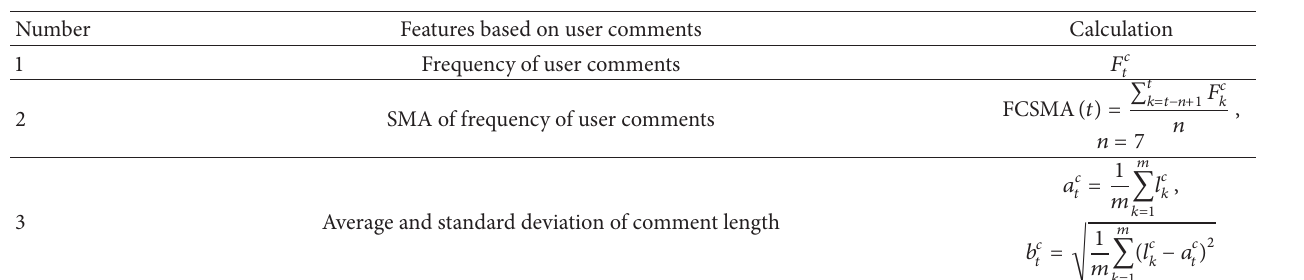
Table 4: List of features based on user